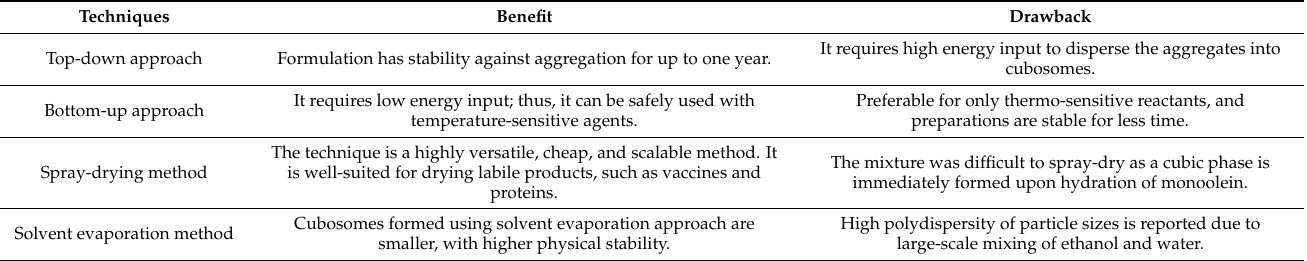
Table 2. Comparison of techniques.